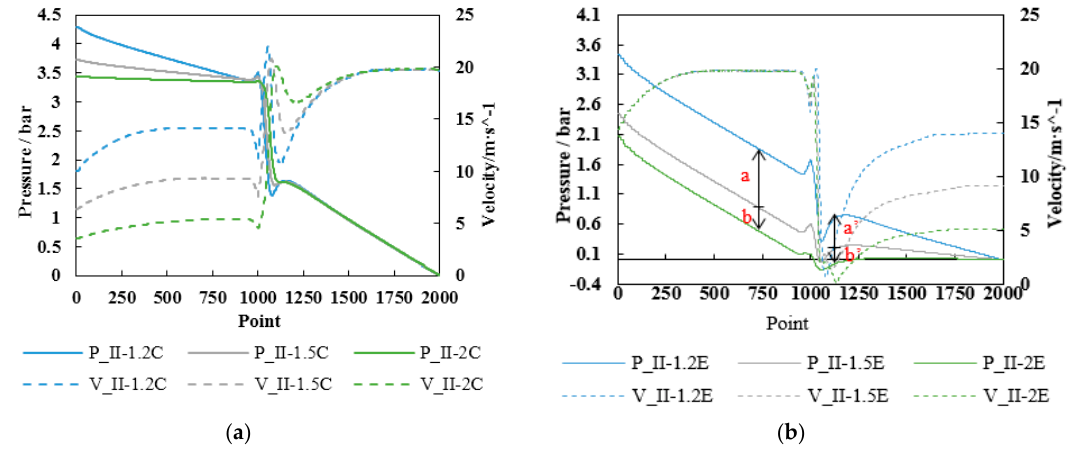
Figure 9. Pressure and velocity distribution when δ 1 = 2: ( a ) contraction and ( b ) expansion.